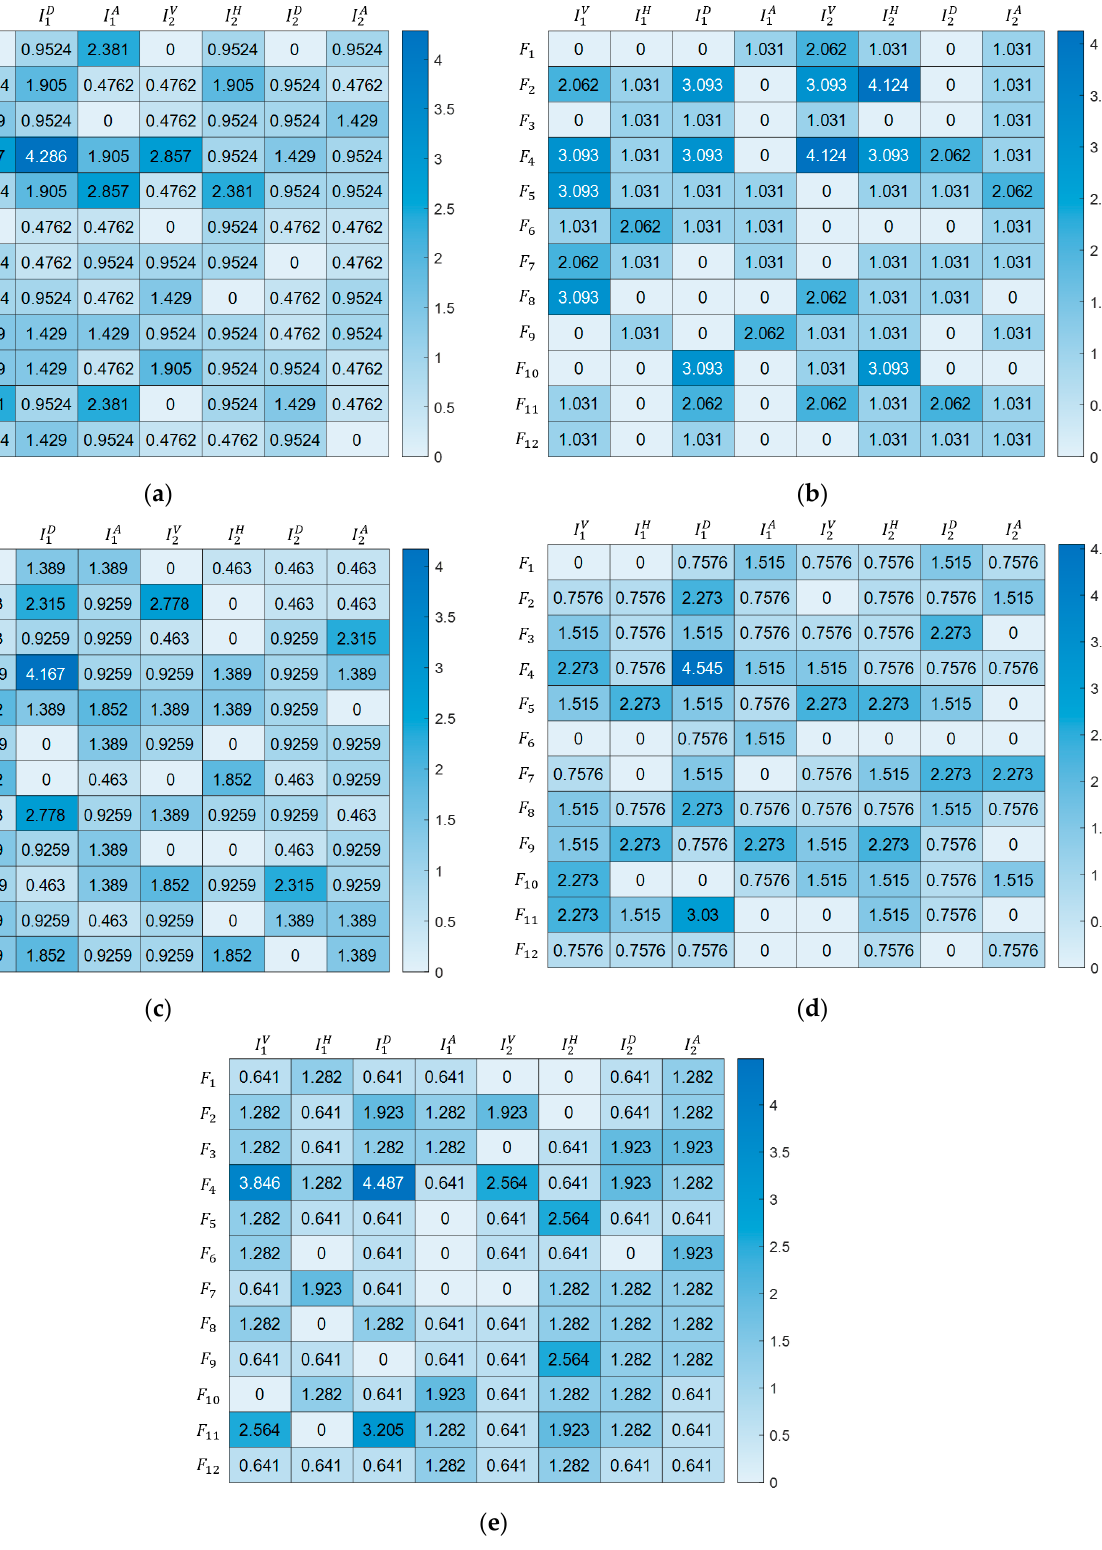
Figure 6. Heat map of selected features of all iterations of FPA for the ( a ) biorthogonal, ( b ) Coiflet, ( c ) Daubechies, ( d ) Fejer–Korovkin, and ( e ) symlet wavelet families.